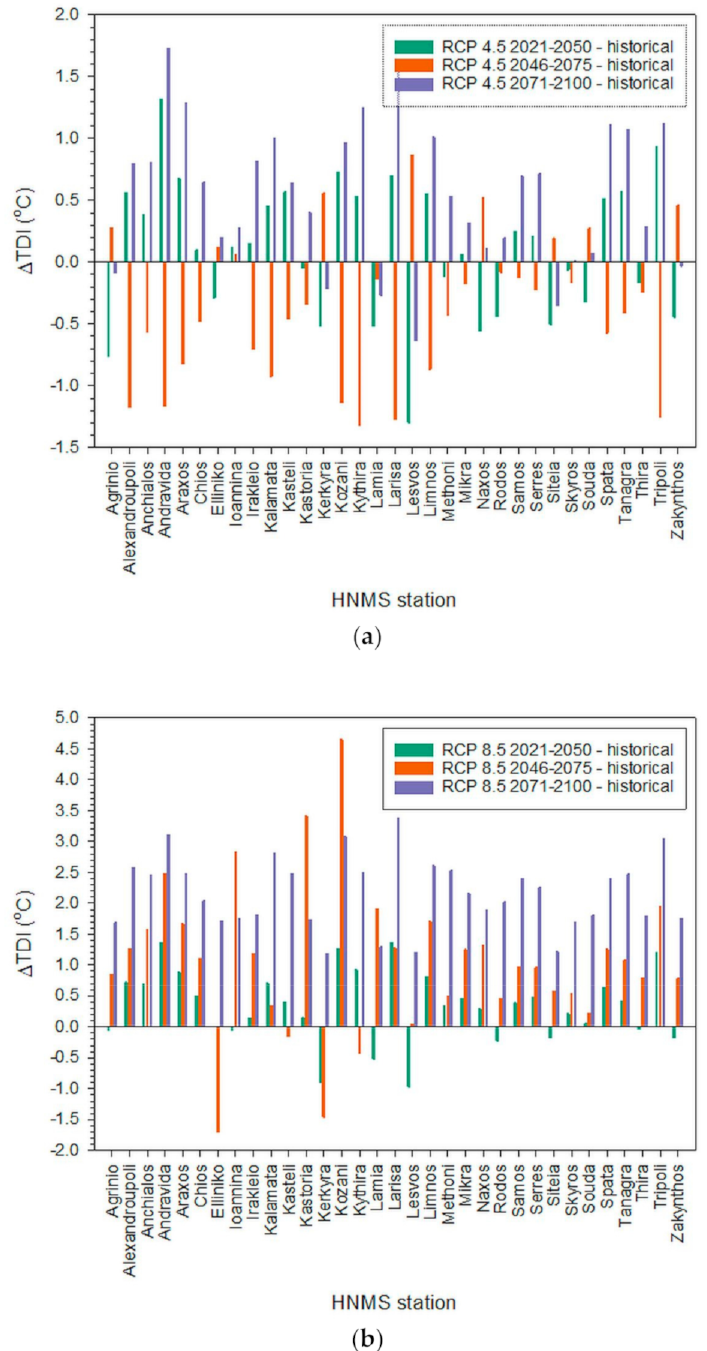
Figure 4. Summer (JJA) mean ∆ TDIs for all HNMS sites (in alphabetical order) as derived from the TMYs-MC during the historical period of 1985–2014 and the future epochs of 2021–2050, 2046–2075, 2071–2100 under the ( a ) RCP 4.5 and ( b ) RCP 8.5 IPCC scenarios. The definition of ∆ TDI is given in the